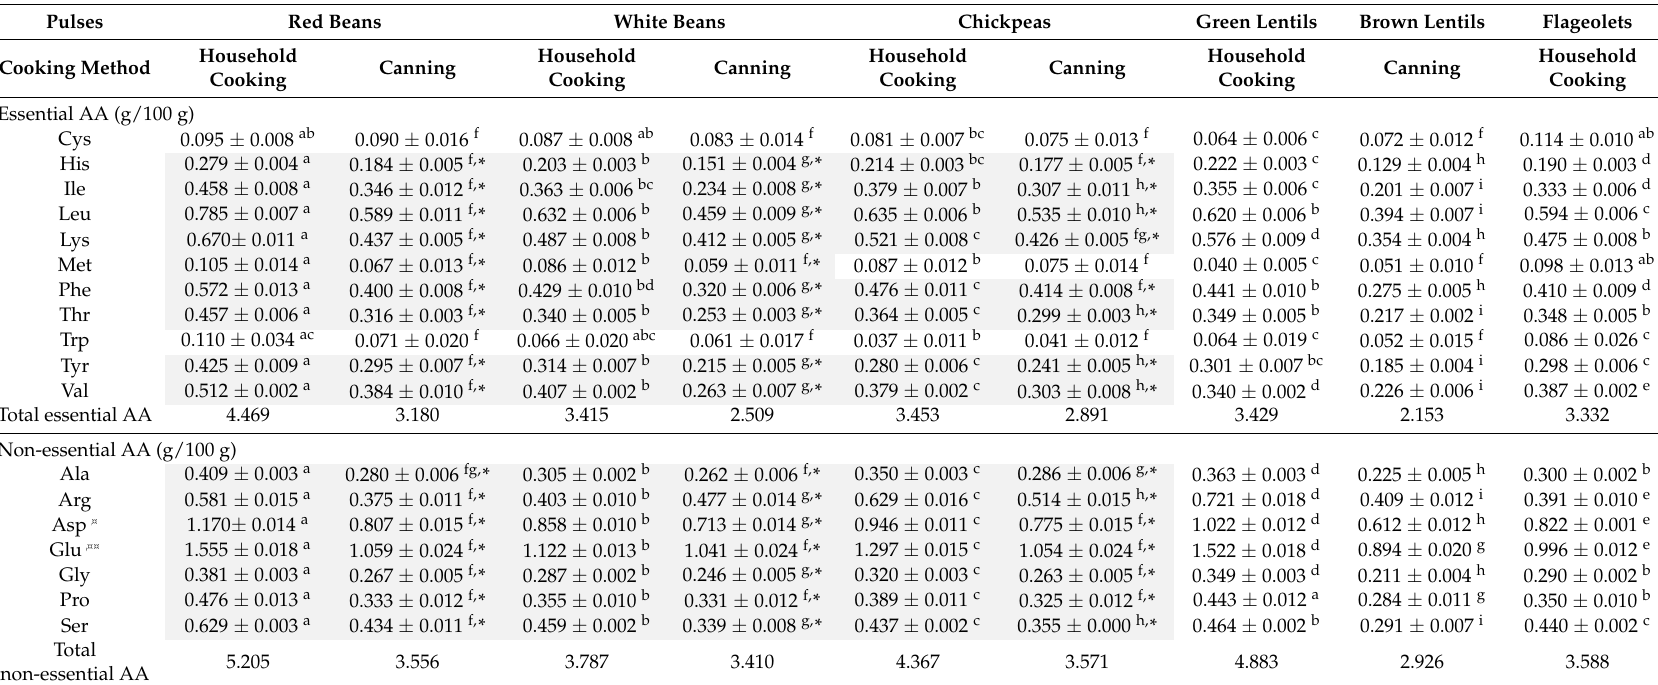
Table 2. Amino acid content of prepared kidney beans, white beans, chickpeas, green and brown lentils, and flageolets.